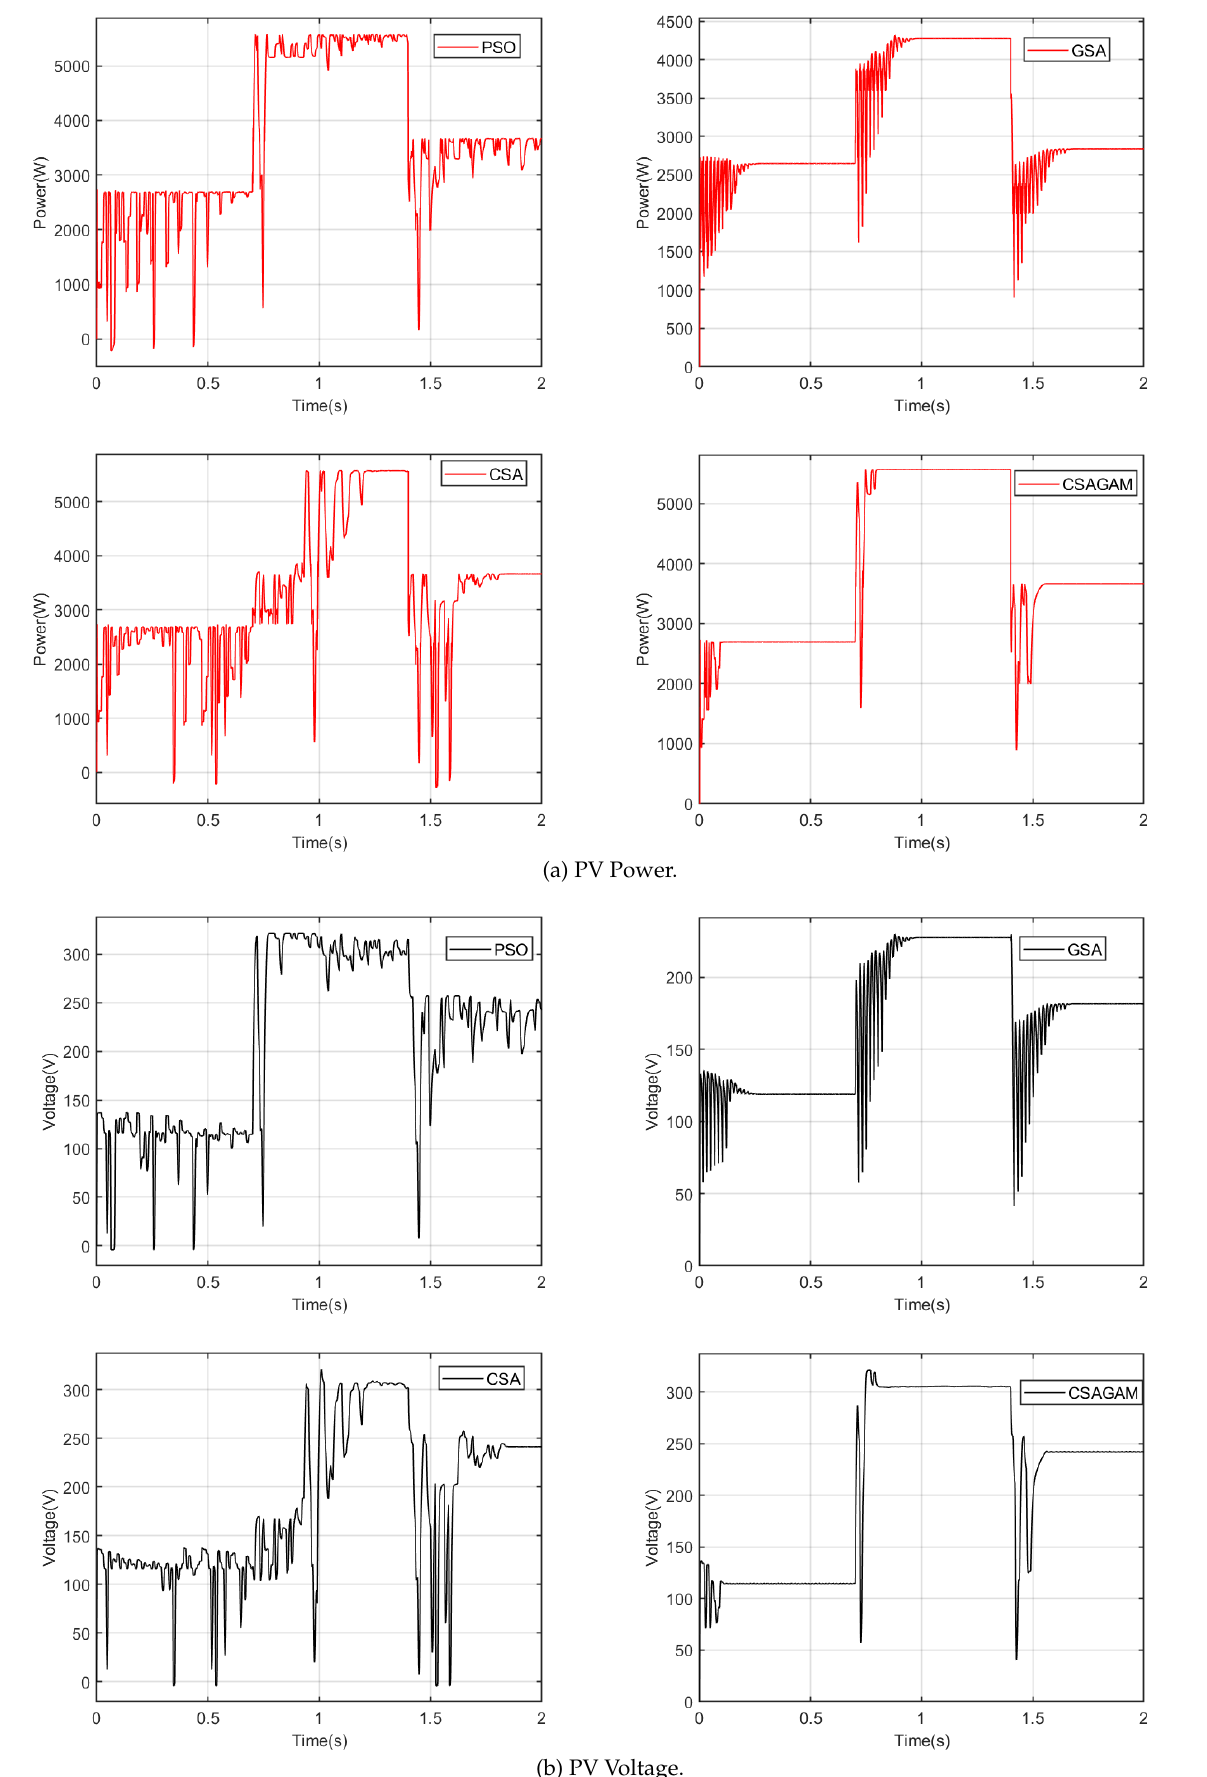
Fig. 10. Simulation results for the changing partial shading PSC 3-PSC 1-PSC